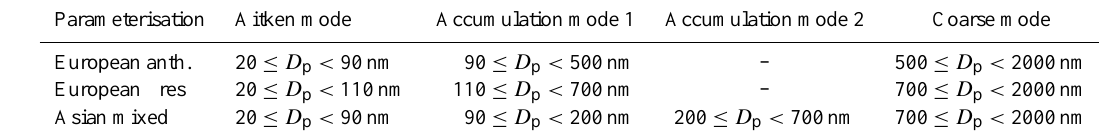
Table 3. Constraints used in the log-normal parameterisations for aerosol modes. Parameterisation Aitken mode Accumulation mode 1 Accumulation mode 2 Coarse mode European anth.